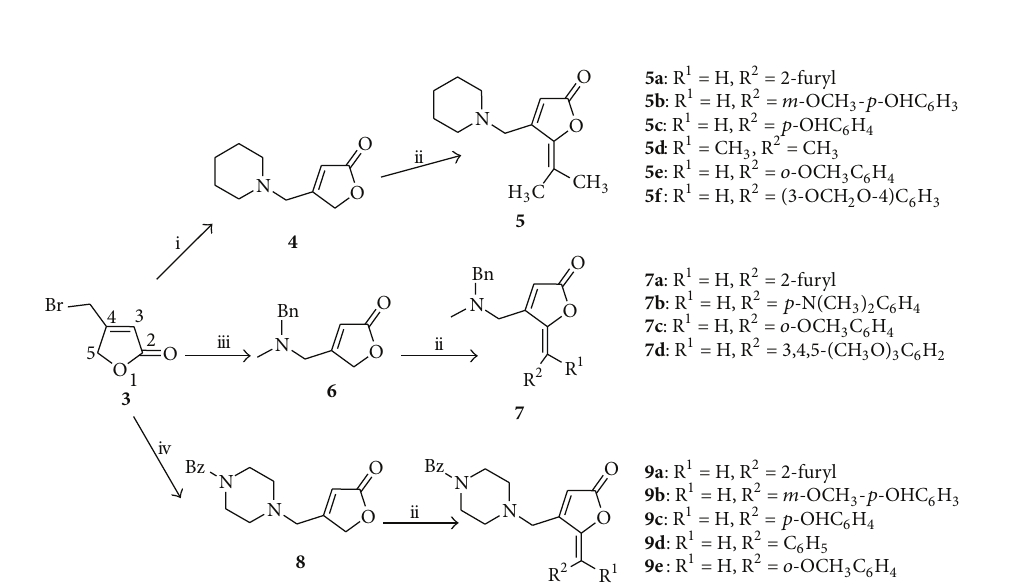
Figure 1: Representative examples of 𝛾 -alkylidene